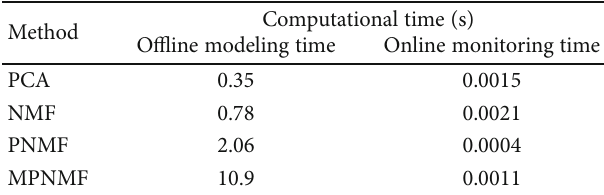
Table 3: Computational